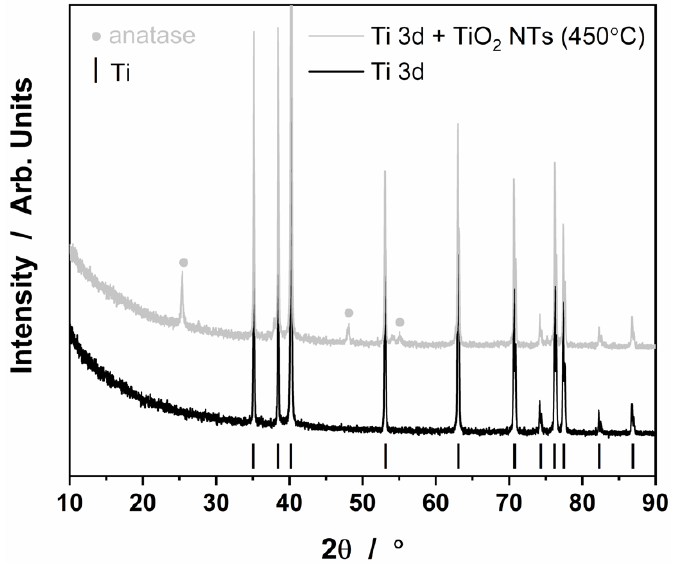
Figure 4. XRD patterns for the Ti 3D substrate after PBF-LB process and annealed at 450